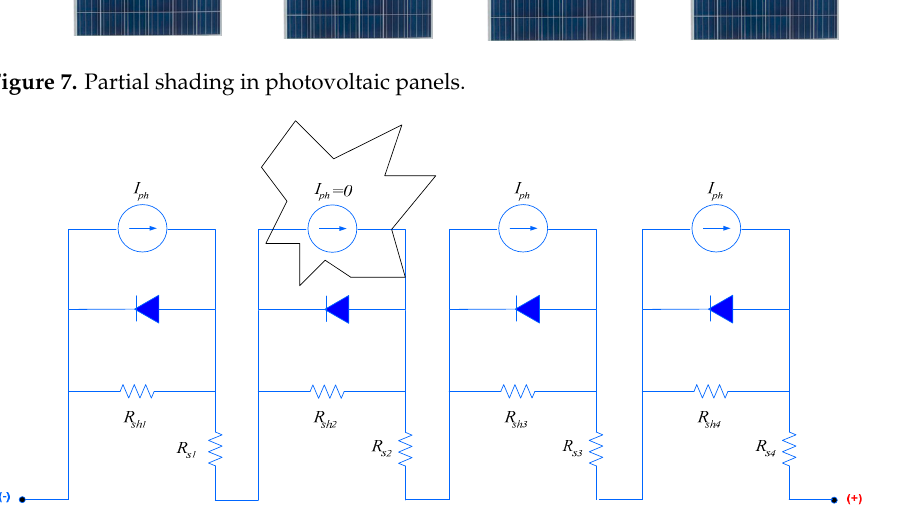
Figure 8. Equivalent circuit of photovoltaic panels with partial shading.